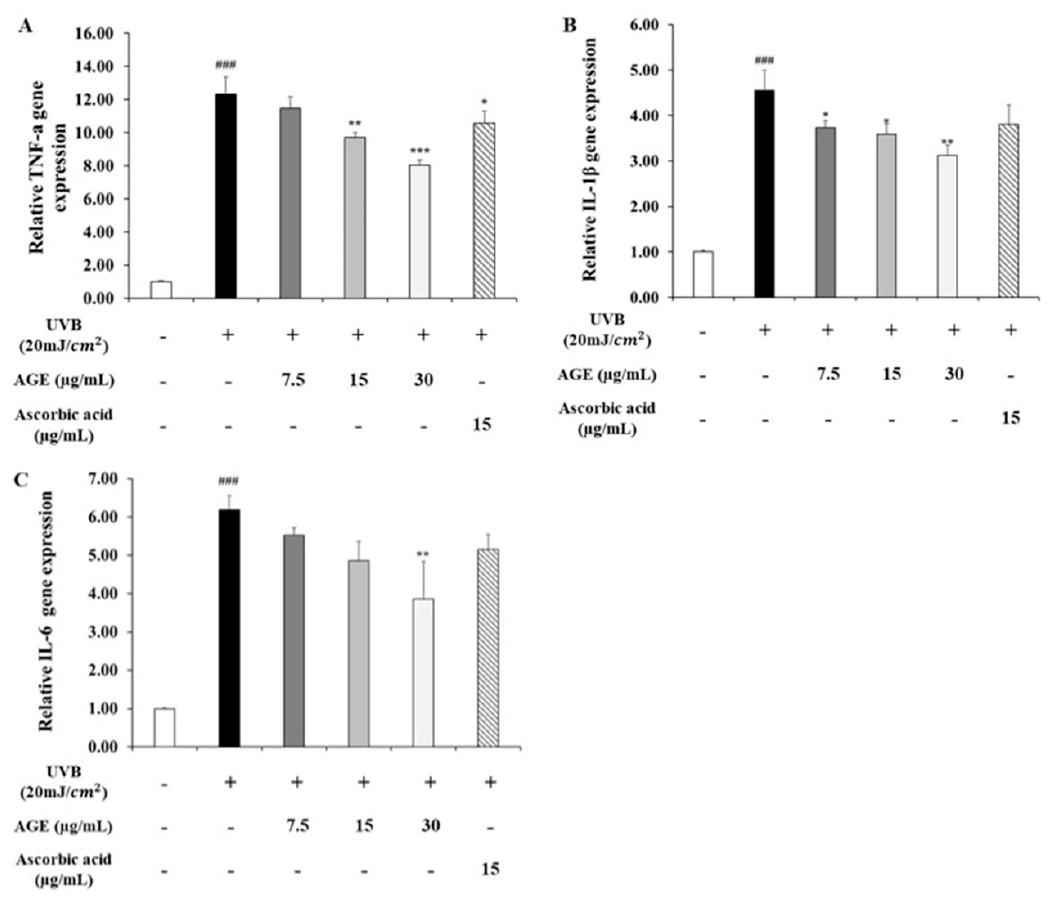
Figure 7. Effects of AGE on the expression of inflammatory cytokines in UVB-irradiated HDFs. HDFs were irradiated with UVB (20 mJ/cm 2 ), followed by treatment with 7.5, 15, and 30 µ g/mL of AGE. After 24 h of incubation, gene expressions of TNF α ( A ), IL1 β ( B ), and IL6 ( C ) were measured by qRT-PCR. All data were expressed as the mean ± SD of at least three independent experiments. ### p < 0.001 versus untreated cells, * p < 0.05, ** p < 0.01, and *** p < 0.001 versus UVB-irradiated cells.